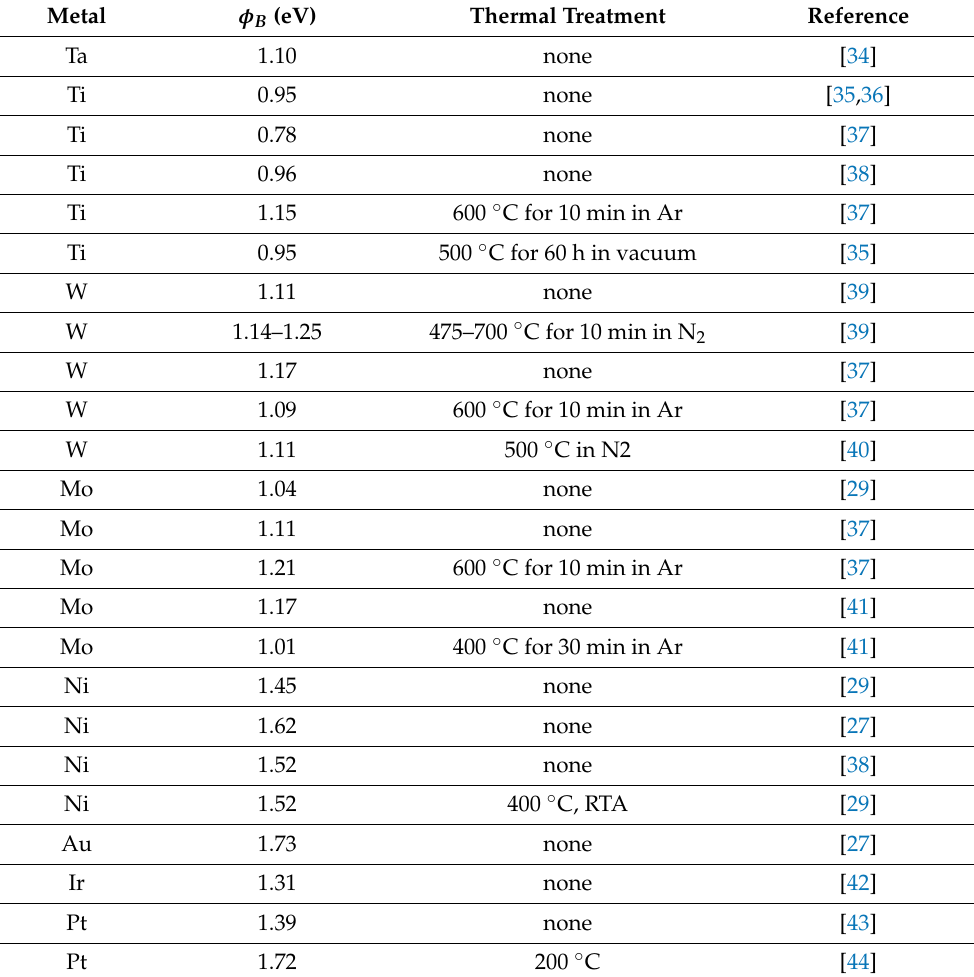
Table 1. Schottky barrier height for metal/n-type 4H-SiC system for different metals. The values were determined by I–V measurements on Schottky diodes.